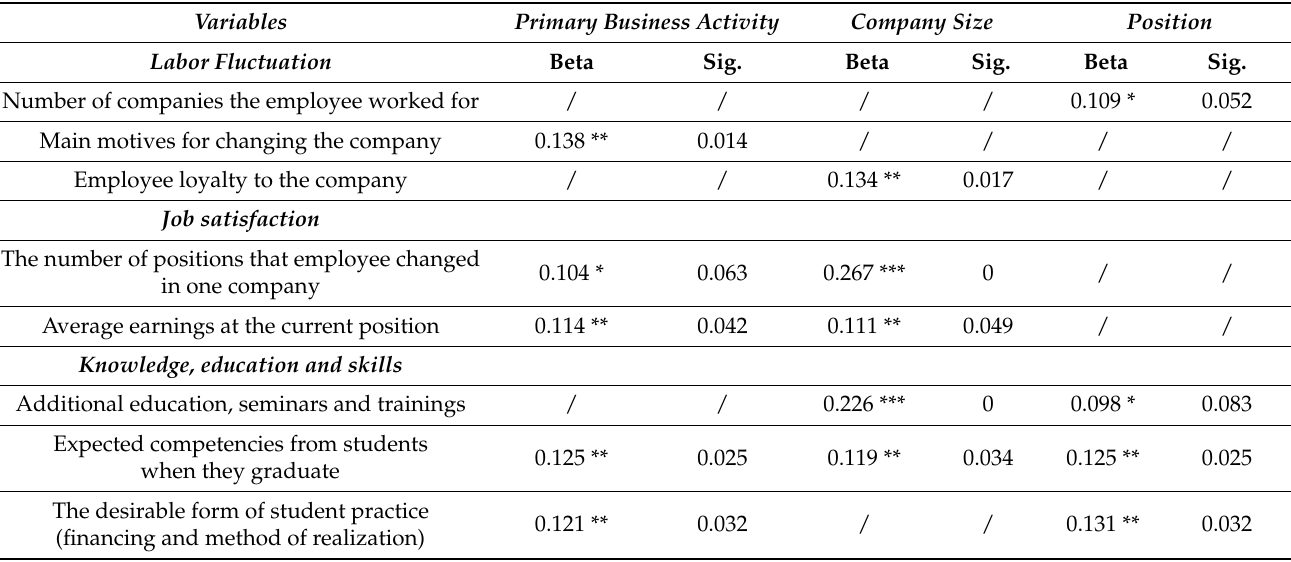
Table 3. Linear regression